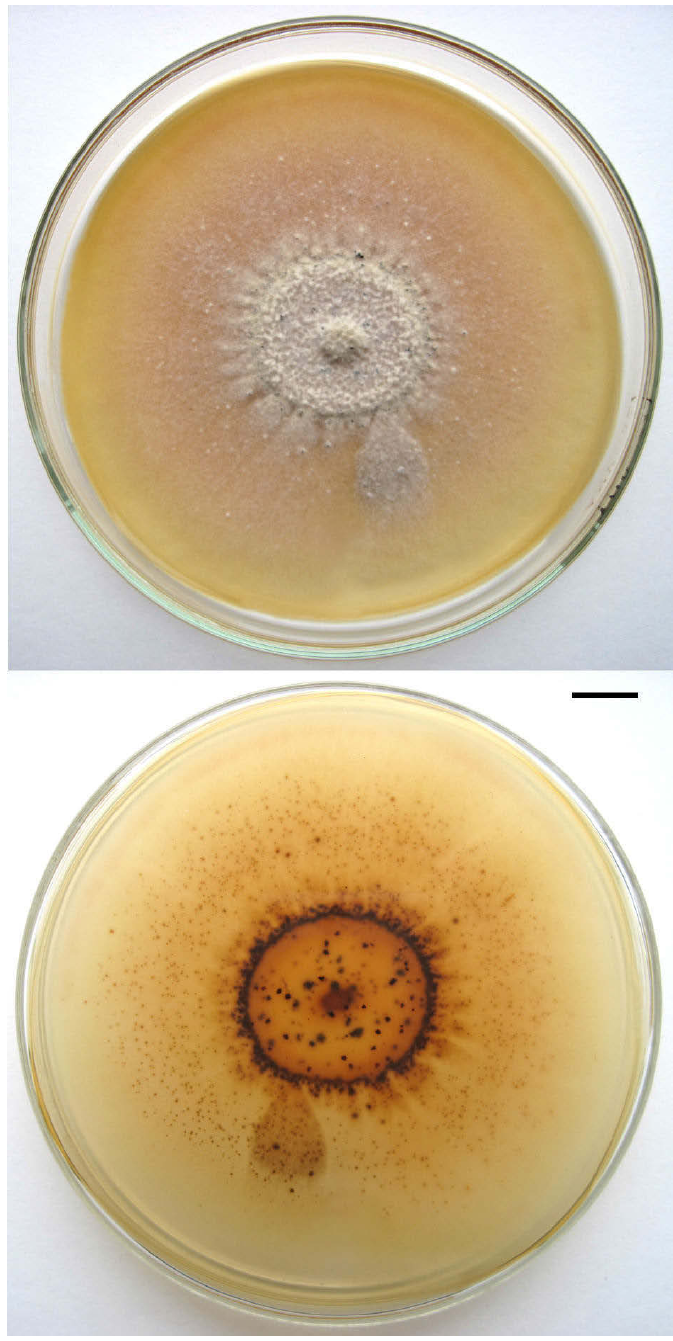
Fig. 1. Two-weeks old culture of Robillarda sessilis on 2% MEA: face of the mat (above) and reverse (below). Scale bar = 1